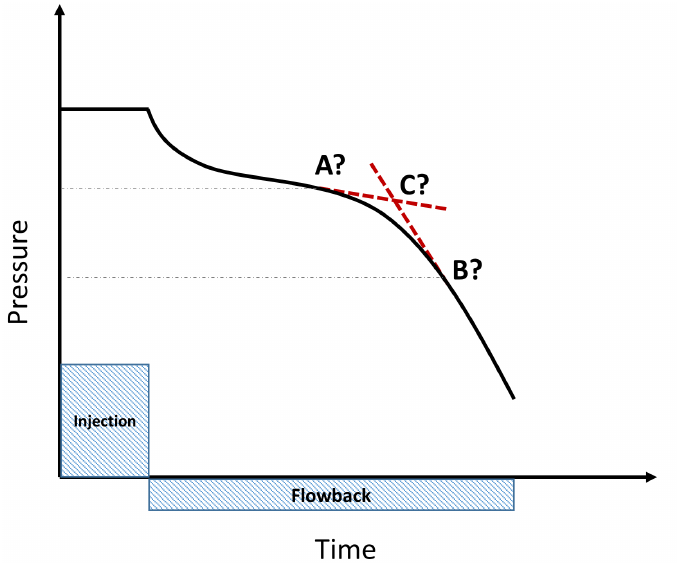
Figure 7. A sketch showing the different interpretations of closure pressure from flowback tests. Point ( A ) closure, according to Nolte and Smith [27], point ( B ) closure, according to Shlyapobersky, et al. [29]. ( A , B ) closure upper and lower bounds according to Soliman and Daneshy [32], and point ( C ) closure according to Plan et al.